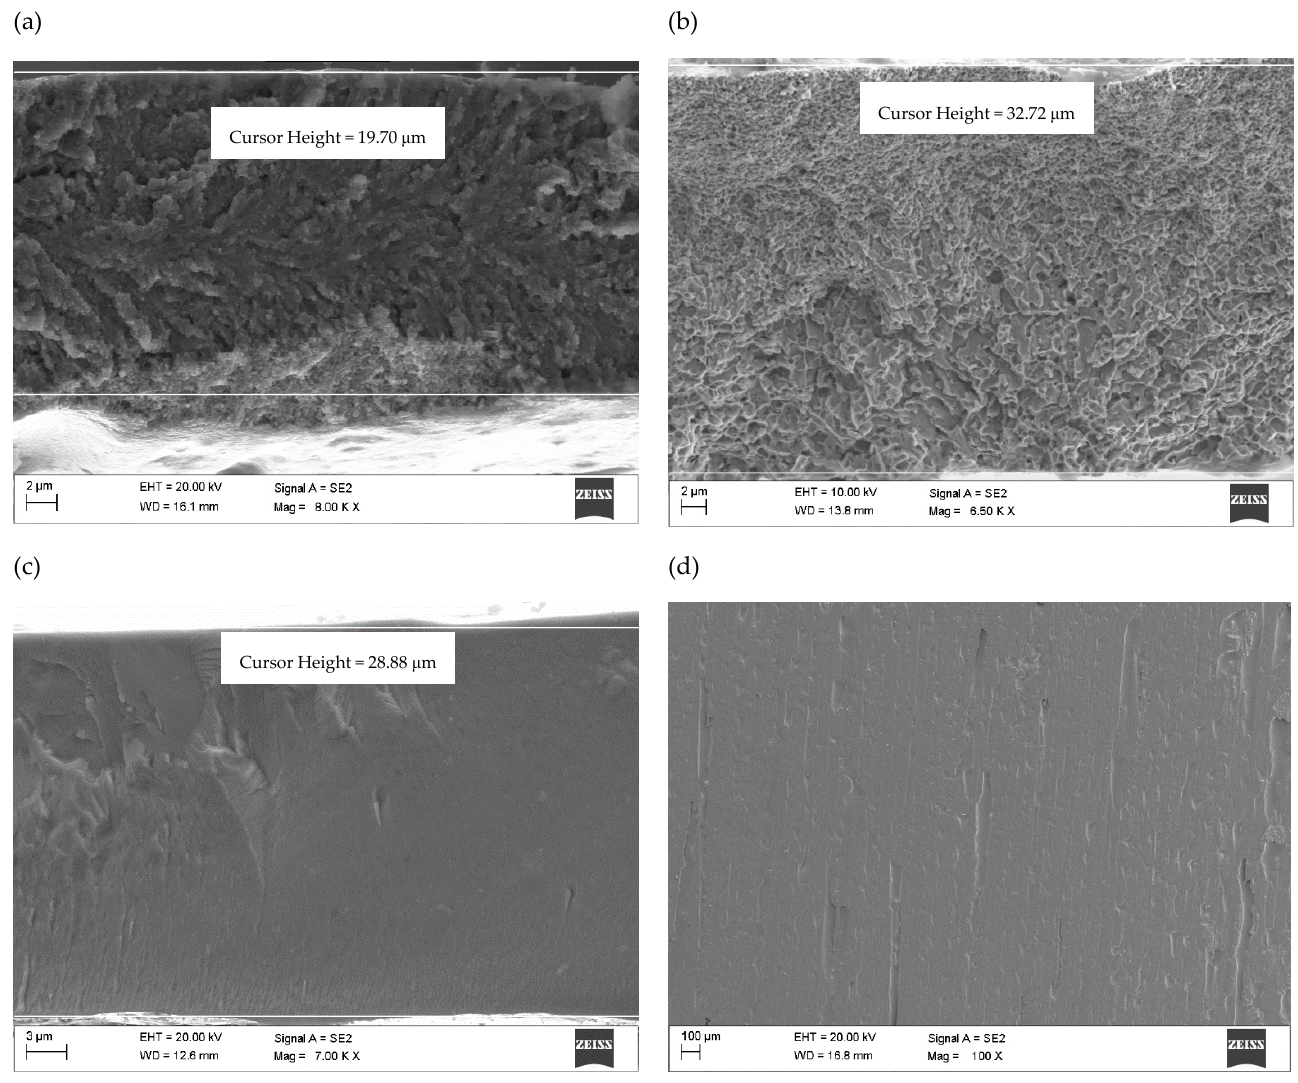
Figure 4. SEM image of the fracture morphology of the La_1 ( a ), La_2 ( b ), La_3 ( c ) alloy tapes with its thickness indicated. SEM image of the surface of the La_3 alloy tape ( d ).